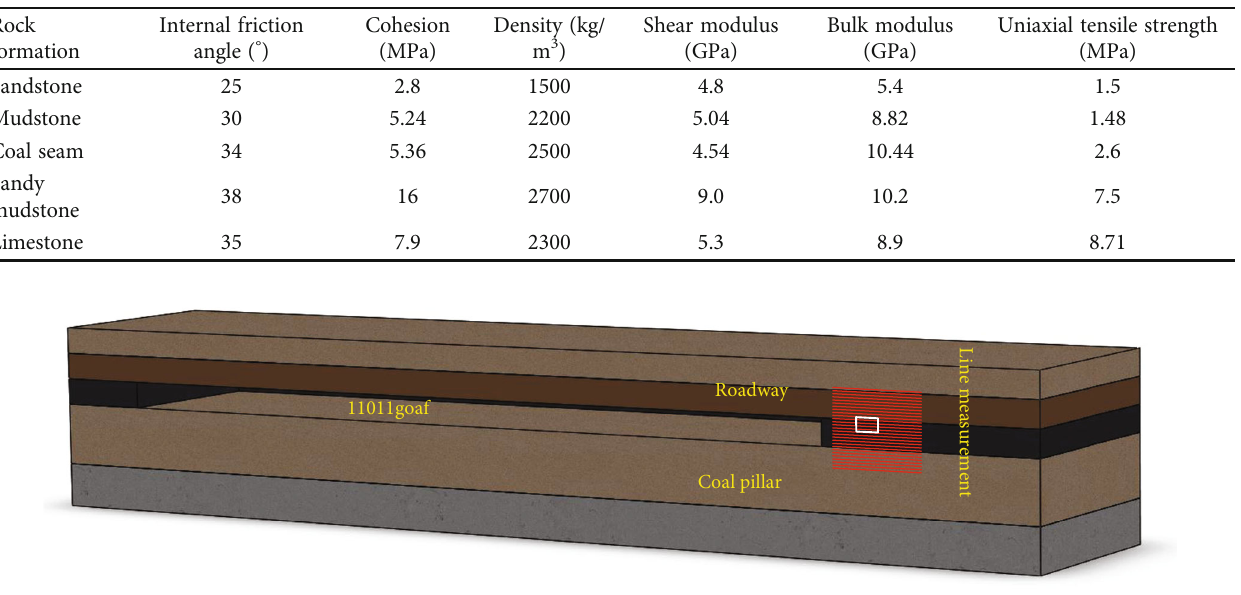
Figure 2: Numerical calculation model. Table 2: Rock physical and mechanical parameters table.